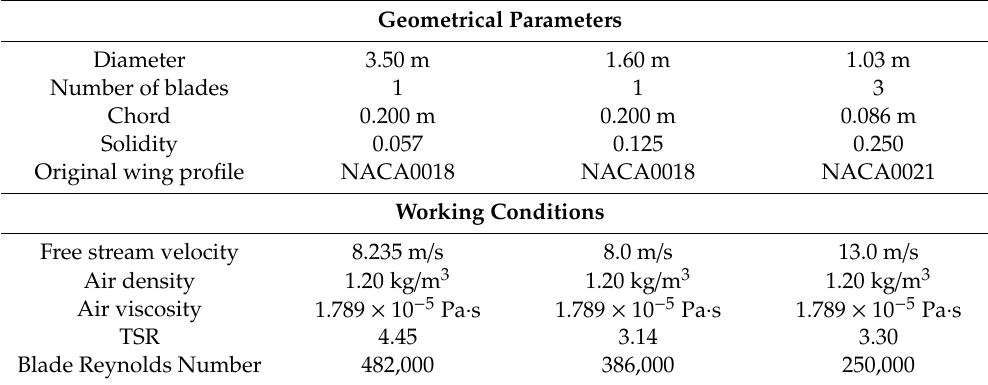
Table 2. Summary of the operational conditions considered for the study